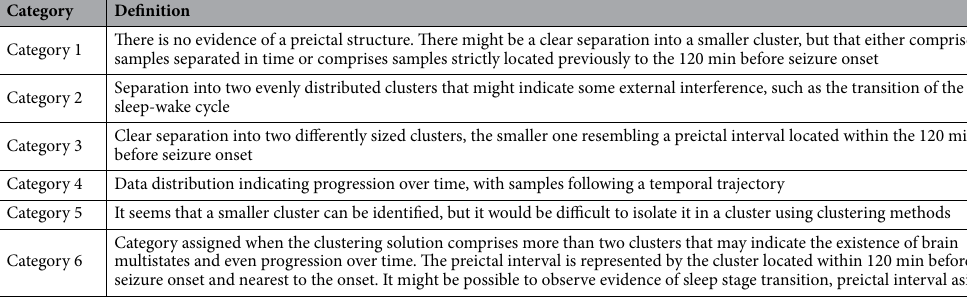
Table 1. Data distribution categories defined after data reduction and clustering solution